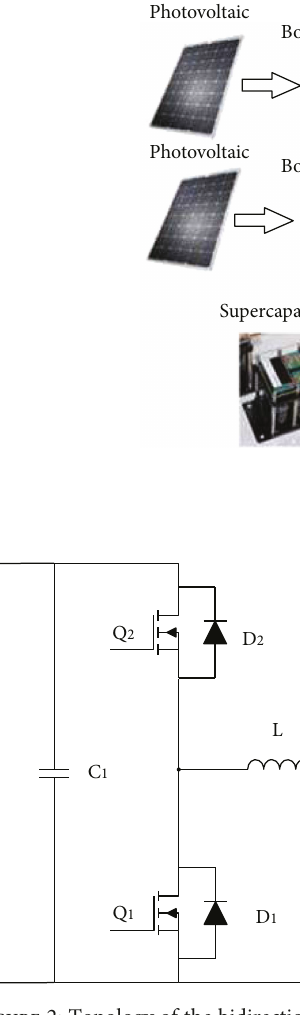
Figure 2: Topology of the bidirectional DC-DC converter.